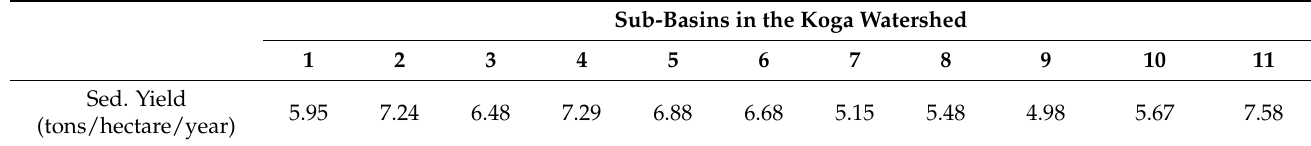
Table 8. The areal distribution of sediment yield in each sub-basin of the Koga watershed.